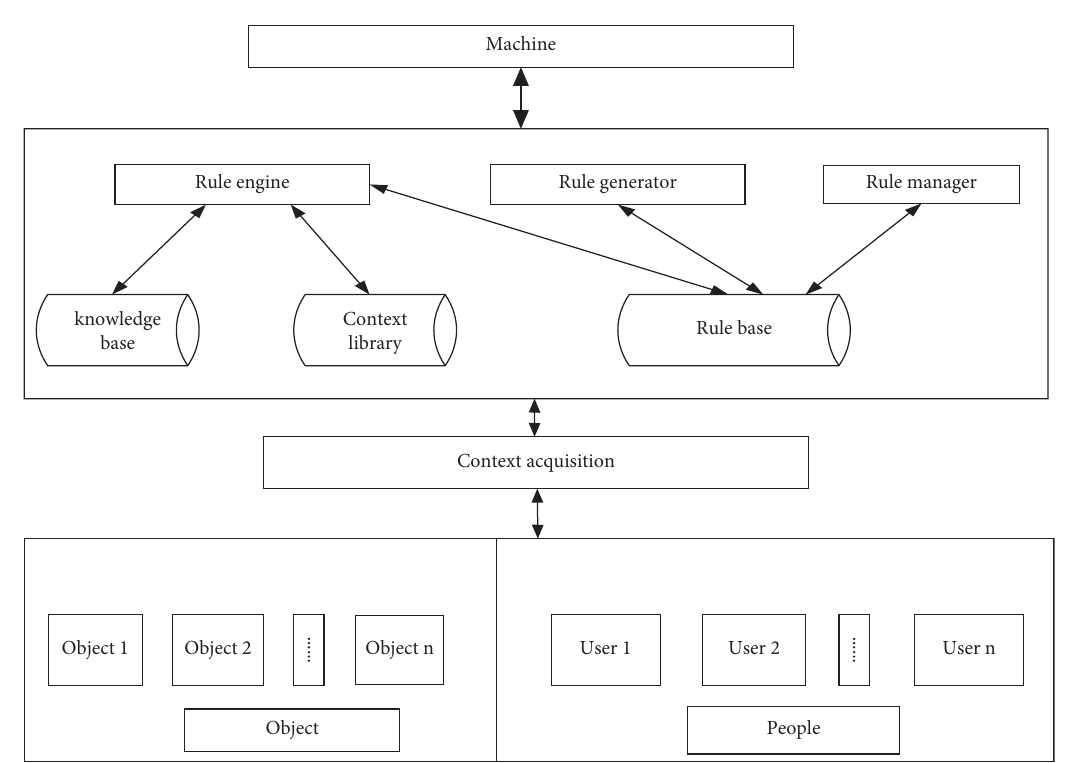
Figure 2: Intelligent interactive system architecture.